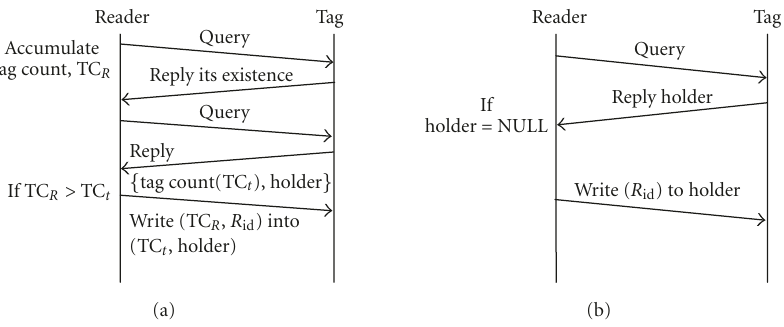
Figure 2: Interaction of redundant reader identification (a) RRE algorithm, (b) LEO algorithm.